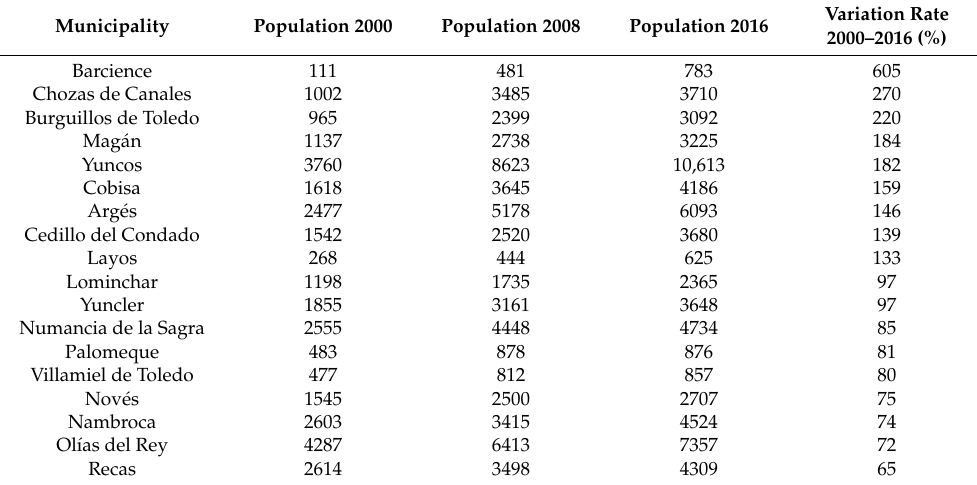
Figure 1. Total population in 2016 and growth rate in the province of Toledo by municipalities for the period 2000–2016. Source: INE [58] and self-elaboration. Table 1. Municipalities of the urban area of Toledo with a growth rate exceeding 50% between 2000 and 2016 Source: INE